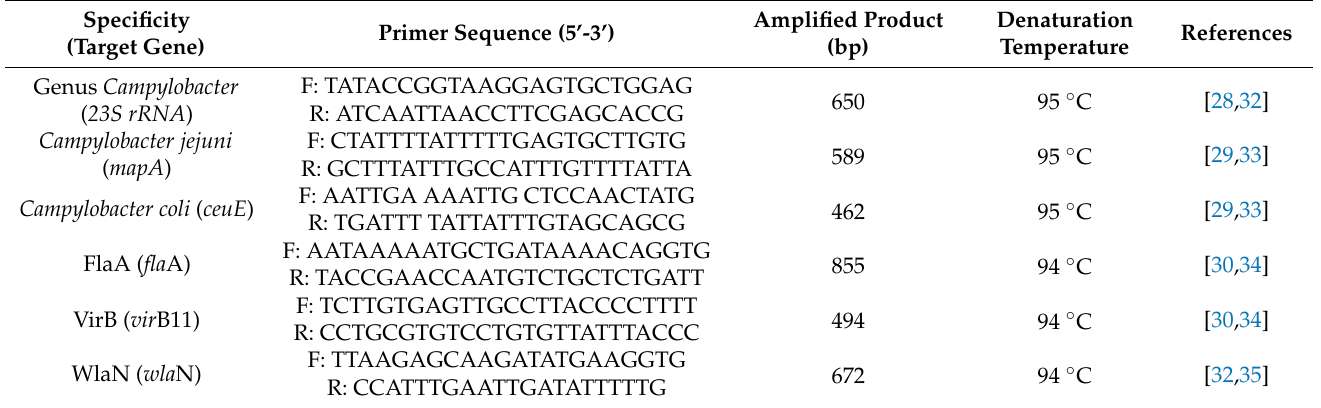
Table 1. Sequences of the oligonucleotide primers targeting six genes of the Campylobacter species and their respective amplified PCR